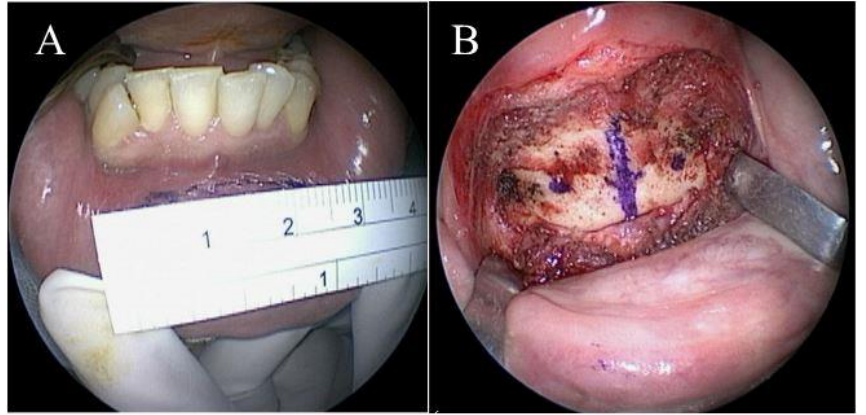
Figure 2. Mandibular vestibular incision ( A ) and marked points for drill on the premandibular plane ( B ).